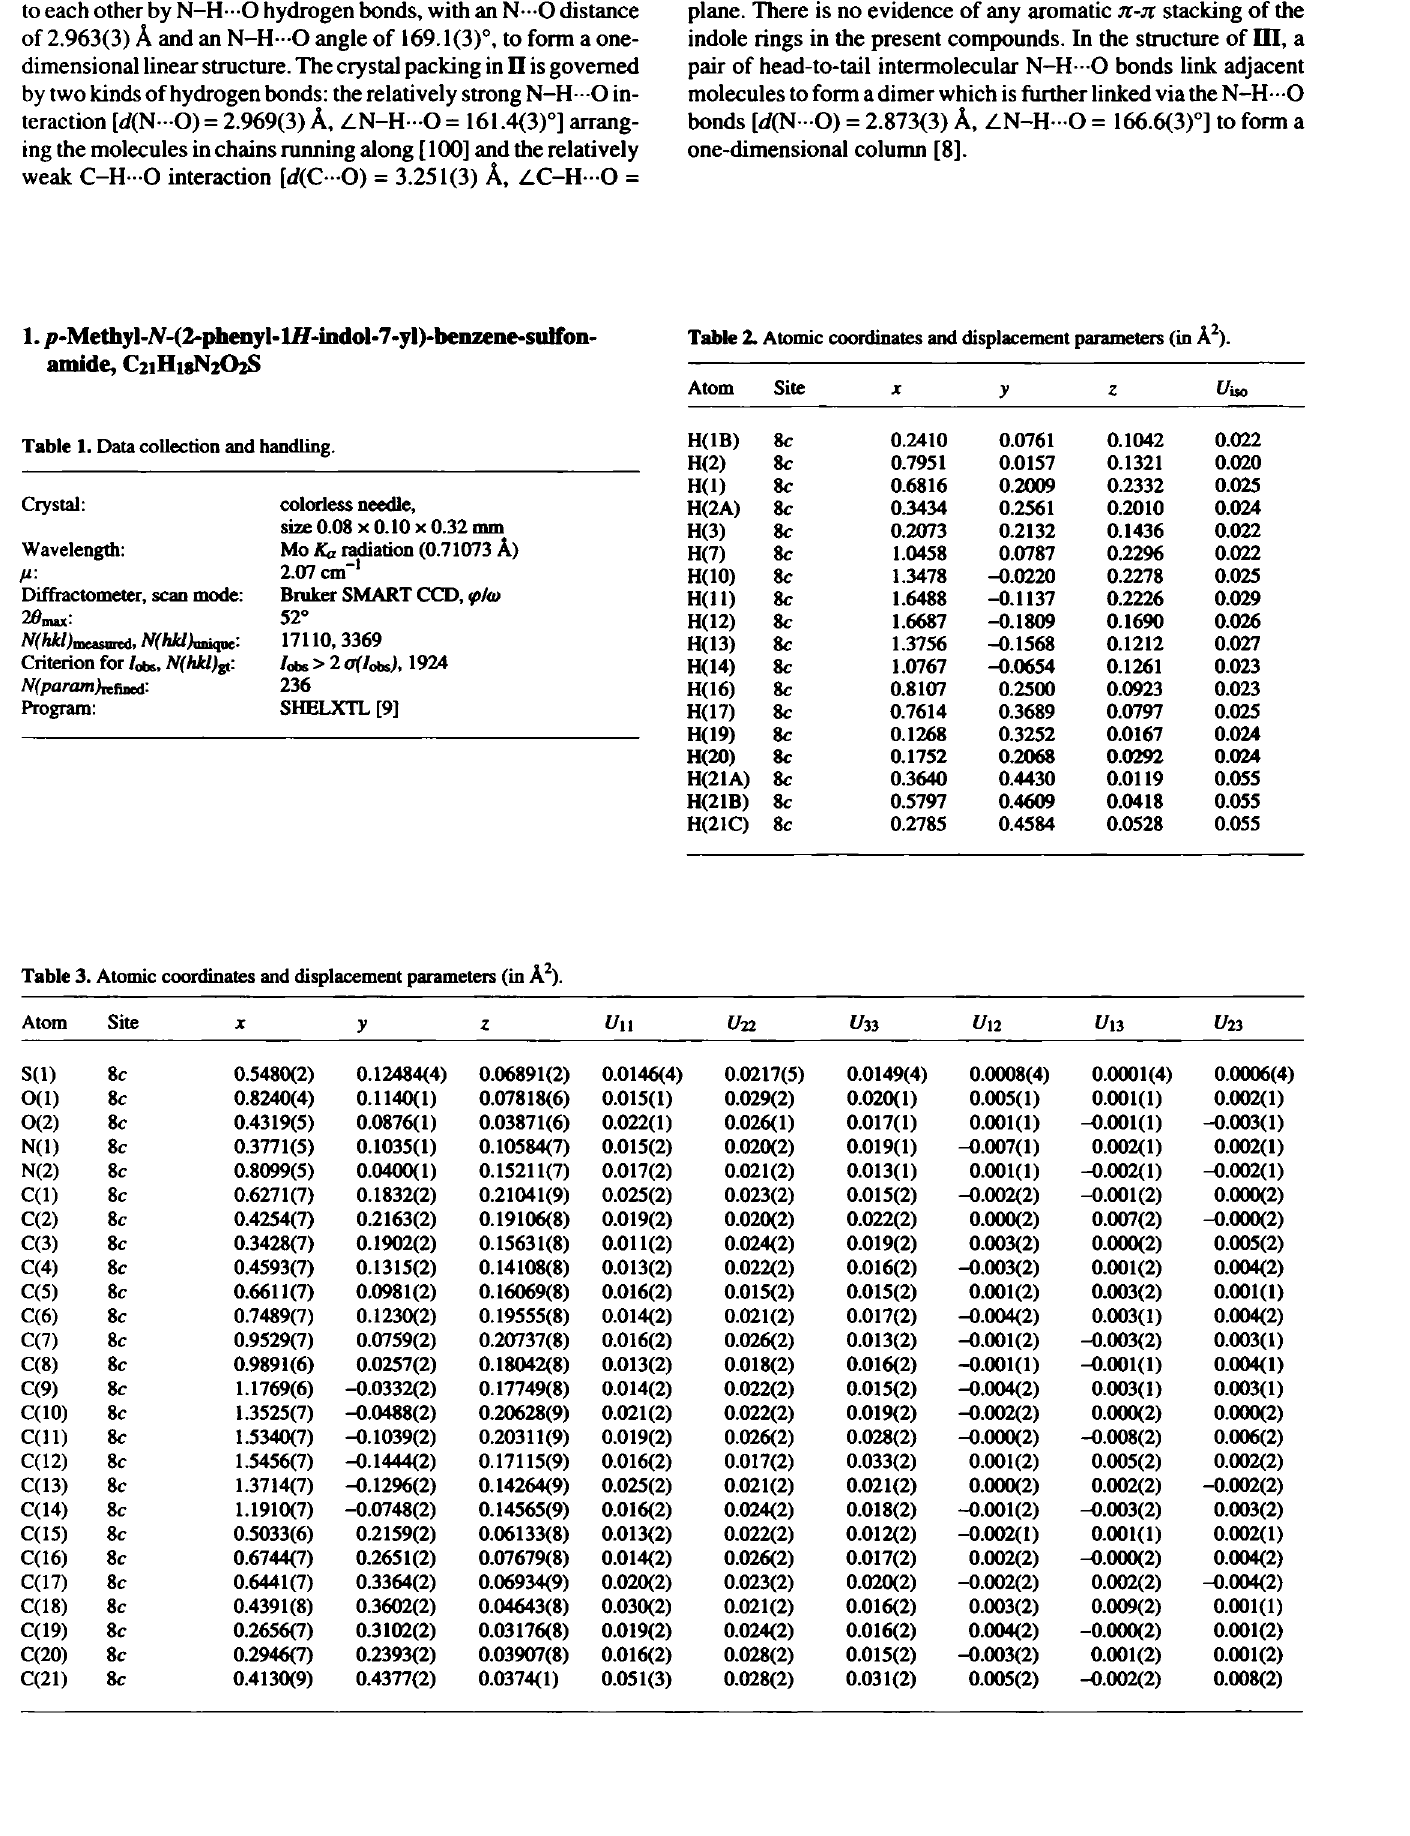
Table 2. Atomic coordinates and displacement parameters (in A 2 ).